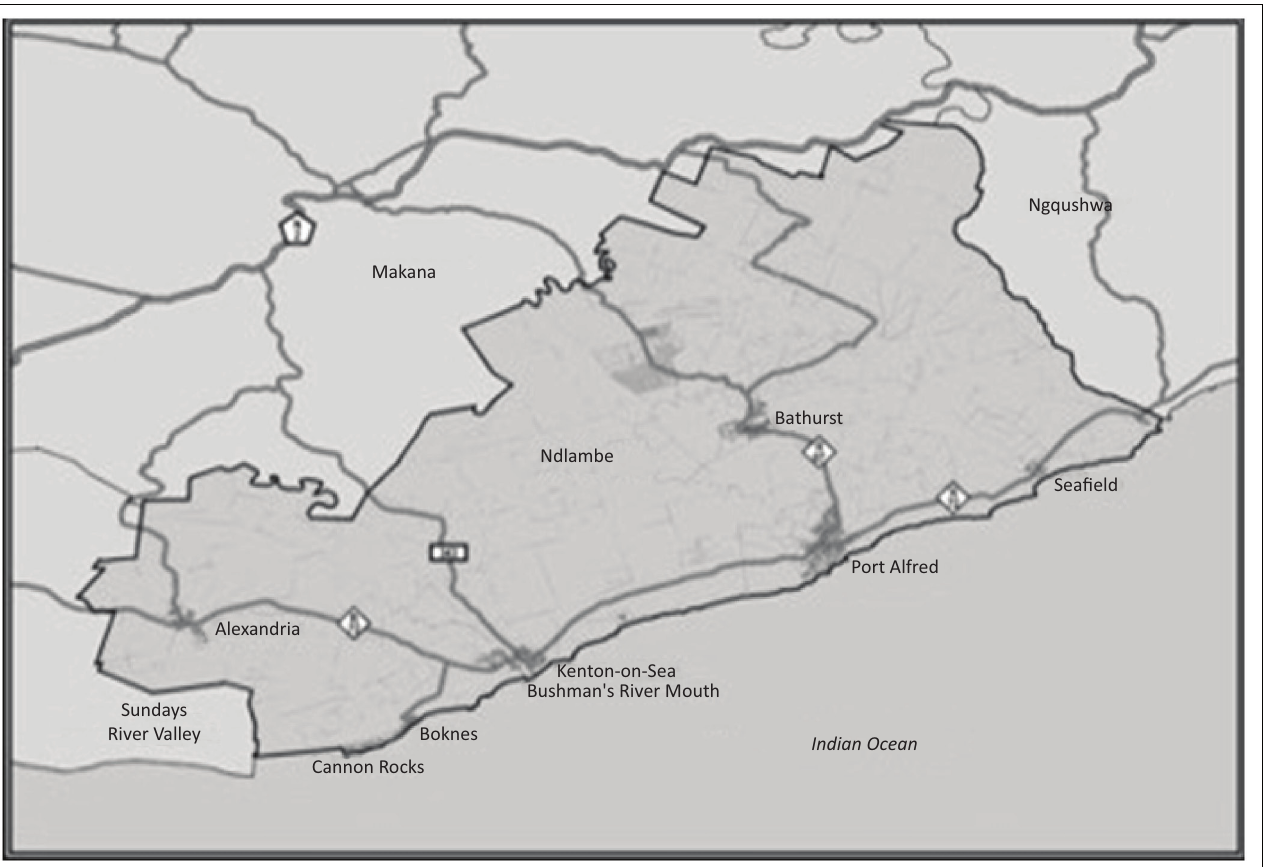
FIGURE 1: The location of Port Alfred within Ndlambe